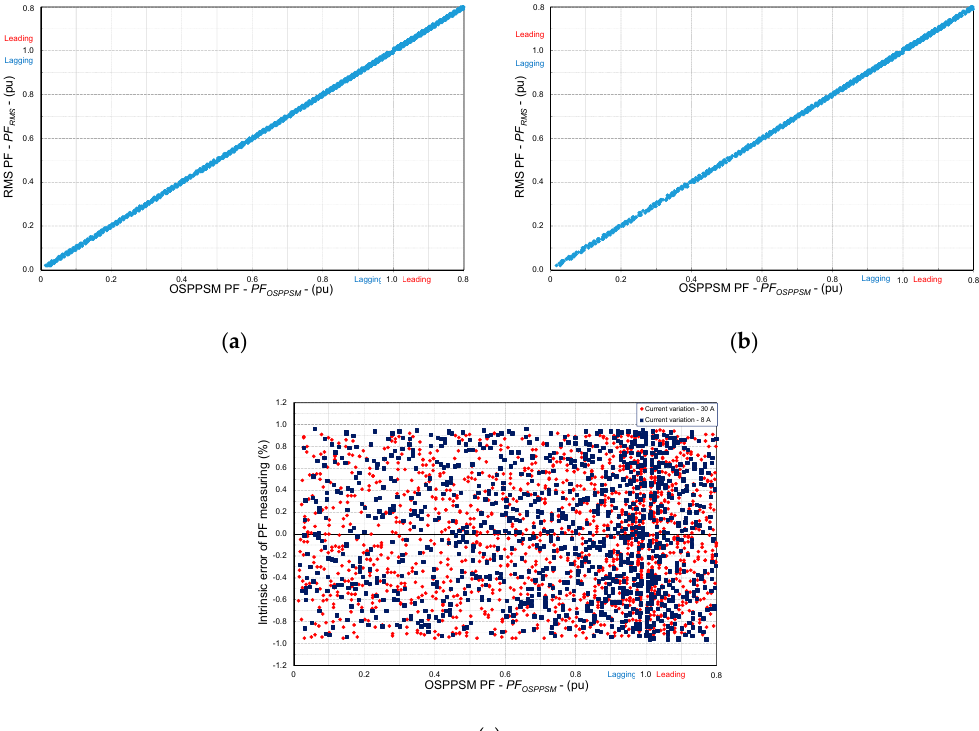
Figure 10. PF meter test: ( a ) 30 A, OSPPSM vs. RMS PF. ( b ) 8 A, OSPPSM vs. RMS PF. ( c ) Intrinsic error of PF measuring, 8 A and 30 A.